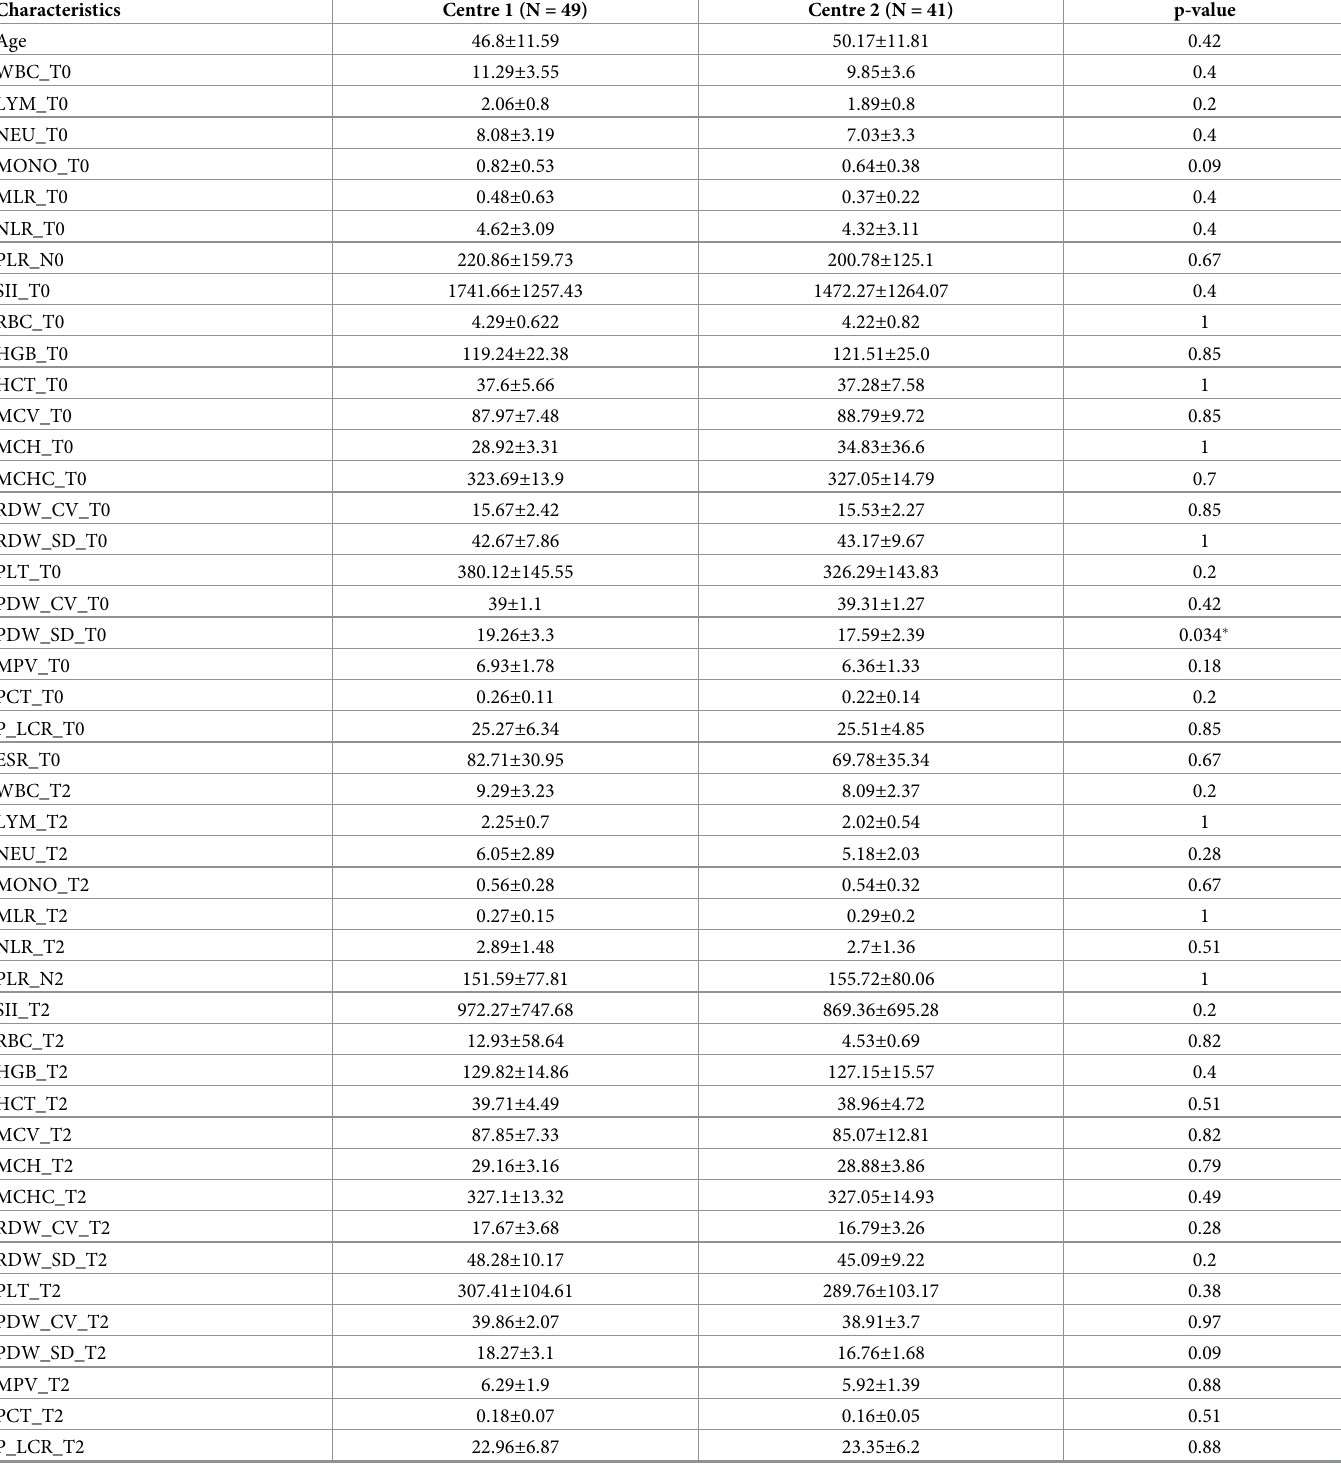
Table 1. Comparison of the 23 hematological parameters by center.